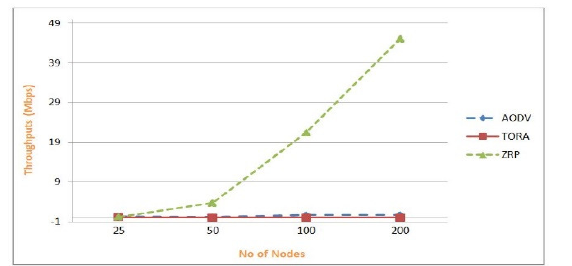
Fig. 4: Throughput vs. Number of Nodes